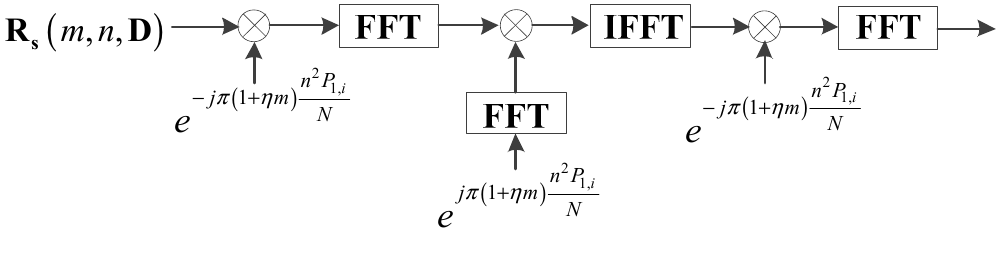
Figure 3. Flowchart of mSFT t , i − FFT τ , i